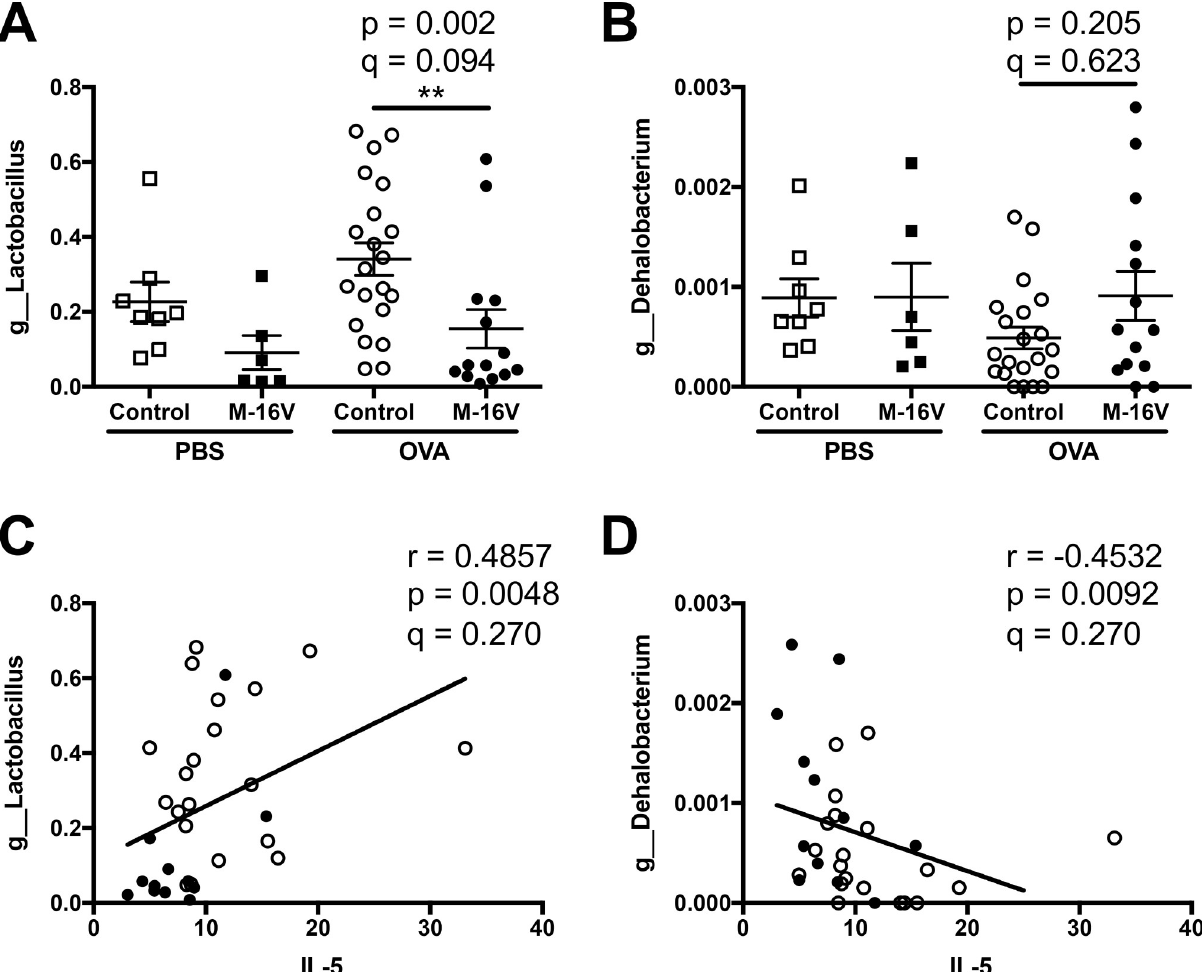
Fig 7. Relationship between IL-5 expression in the lungs and fecal microbiota composition of each sample. Relative abundance of ( A ) g_Lactobacillus and ( B ) g_Dehalobacterium in samples from individual mice. The values are presented as the means ± SEM (n = 6–21). �� P < 0.01 compared between control and B . breve M-16V diet OVA-allergic model mice. Spearman’s rank correlation between the relative abundance of ( C ) g_Lactobacillus or ( D ) g_Dehalobacterium and IL-5 mRNA expression shown in Fig 3B. Q-value is an FDR adjusted p-value.